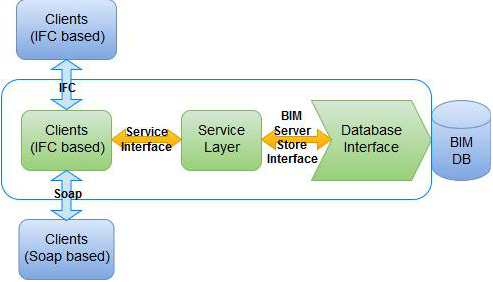
Figure 9. BIMServer architecture (Afsari et al., 2016) 5.2 System architecture Figure 10 shows the architecture of the proposed CloudServerBIM collaboration system for data storage and 3D BIM data viewing. The system is divided into two layers: the back-end and the front-end. Front-end is all the structure involved and what a user is interfacing, which includes some programming languages like PHP, Javascript and HTML. Back-end refers to scripts or programs that are executed on the server itself and are independent from the client's PC.